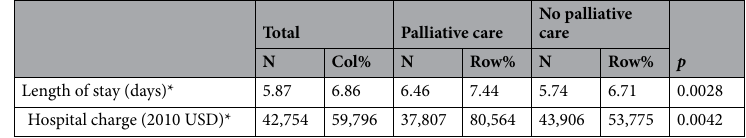
Table 1. Patient and hospital characteristics by palliative care use. *Mean/SD.